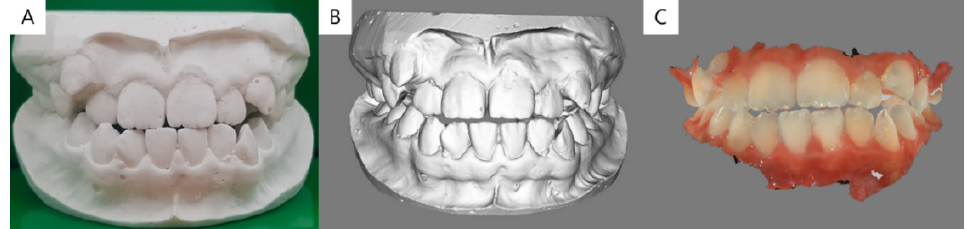
Figure 2. A representative plaster model and images scanned using a model scanner and intraoral